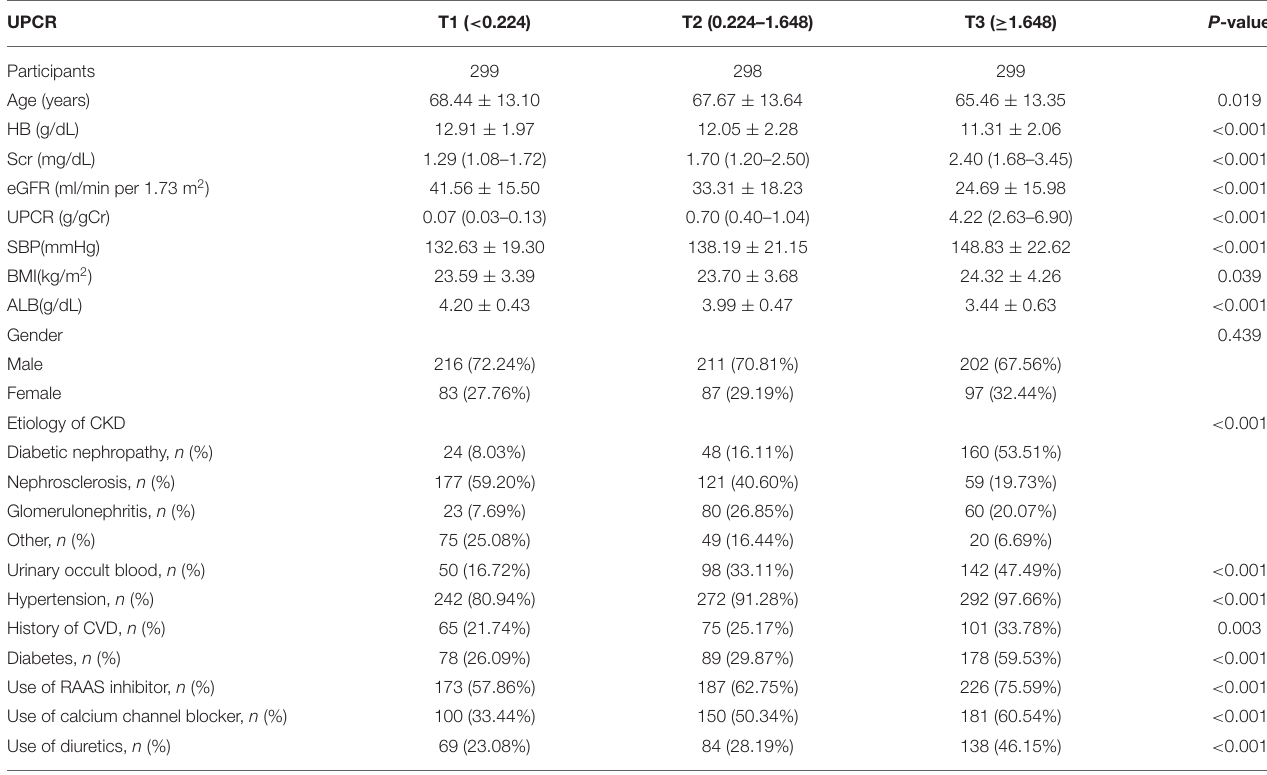
TABLE 1 | Baseline characteristics of all the patients at enrollment ( n = 896). UPCR